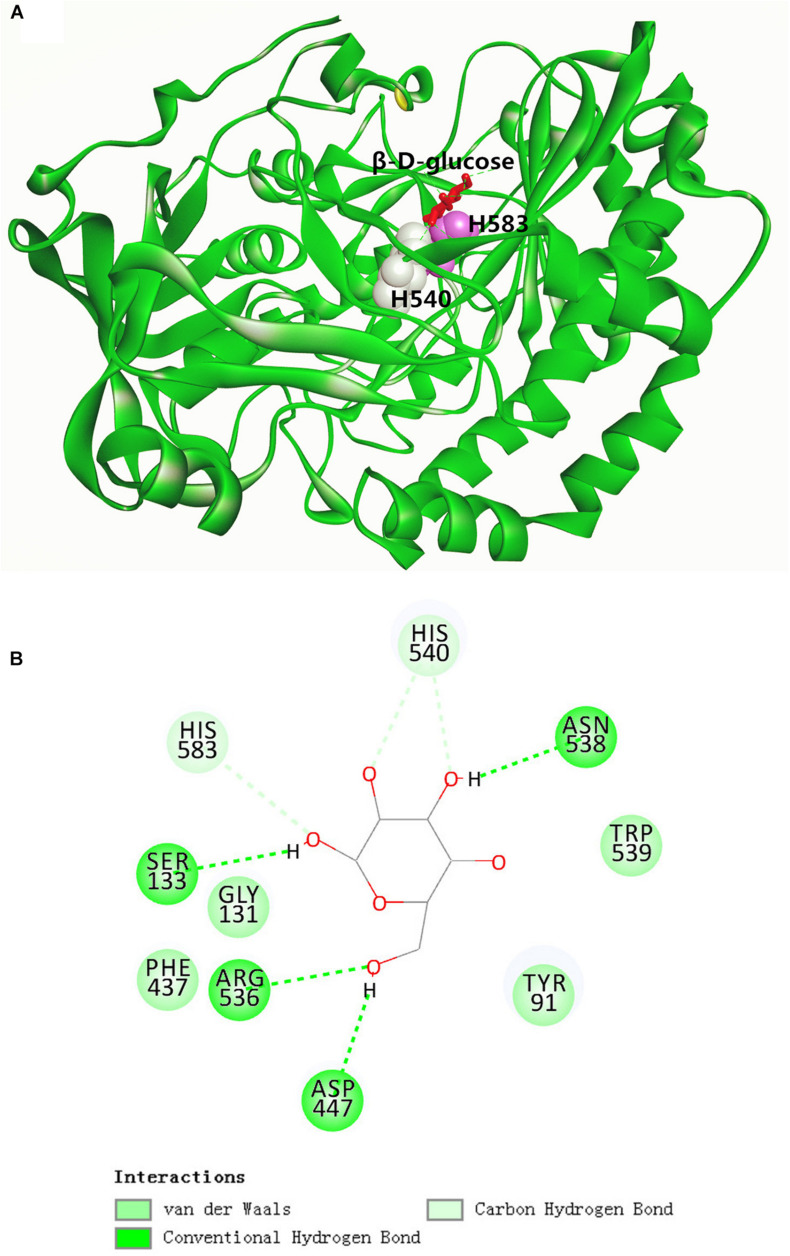
Overall structure of GOxP5 in complex with β-D-glucose (A). Two-dimensional diagrams of non-covalent interactions of β-D-glucose/GOxP5 docking complex (B).